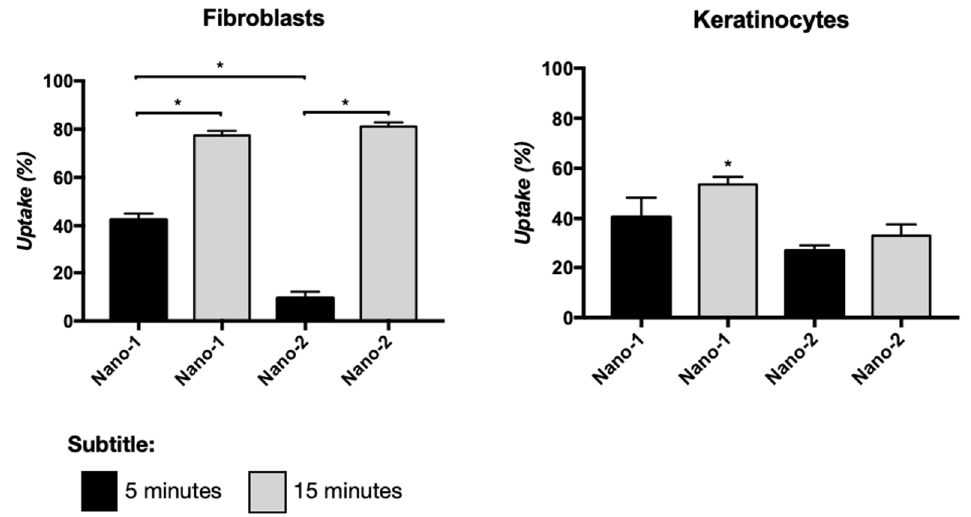
Figure 3. Cellular uptake of Nano ‐ 1 and Nano ‐ 2, at a concentration of 10 11 particles/mL, after 5 and 15 min of contact with a monolayer of fibroblasts and keratinocytes. Results were statistically analyzed using ANOVA, followed by Tukey’s test. (*) indicates statistically significant difference with P < 0.05 (n = 3 determinations).